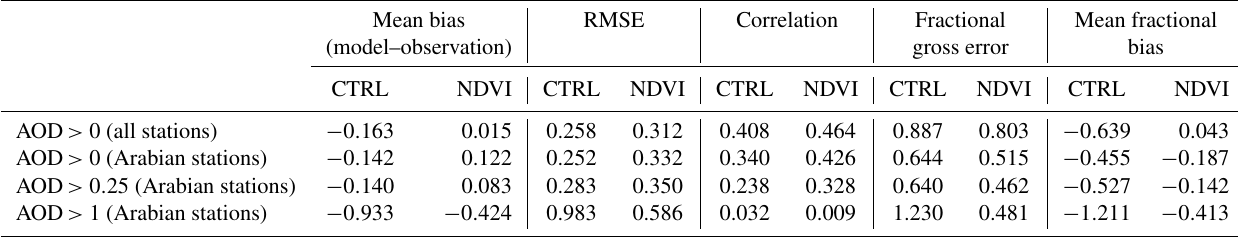
Table 1. Statistical metrics from the comparison between the annual runs and AERONET.